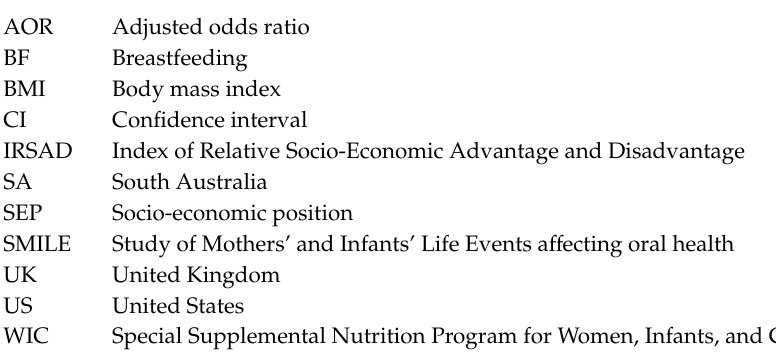
Figure S1: Proportion of children breastfed to each month of age, Table S1: Comparison of characteristics of participants and non-participants and South Australian (SA) pregnancy outcome data for 2013, Table S2: Sensitivity analysis: Factors independently associated with breastfeeding at 12 months and 24 months postpartum with age of return to work